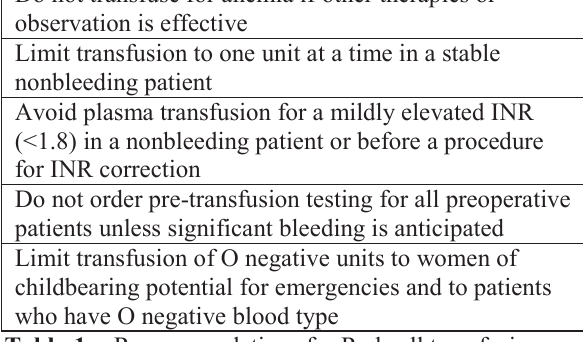
Table-1a: Recommendations for Red cell transfusion based on choosing wisely Canada 14,15,16 Hemoglobin